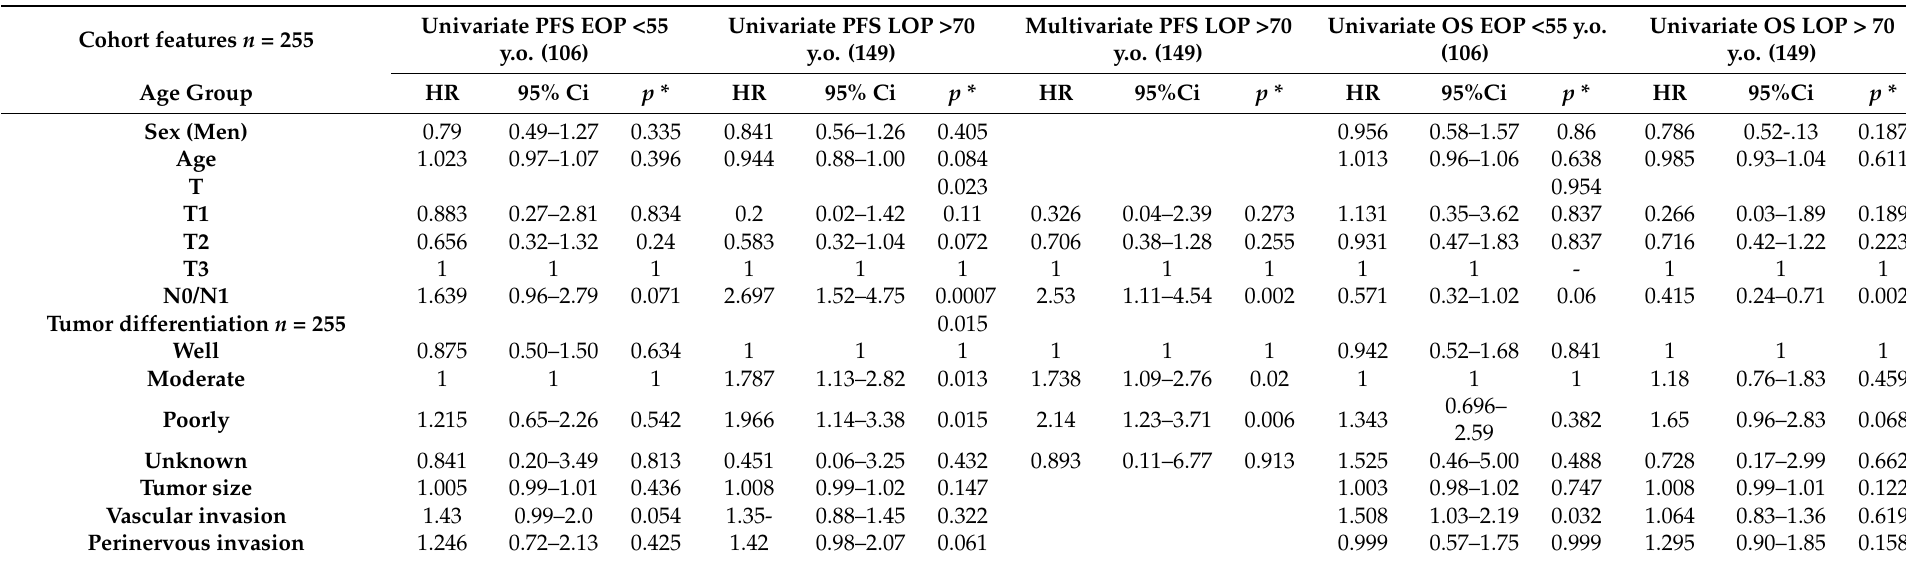
Table 2. Uni- and Multivariate analysis of Overall survival (OS) and Progression-free (PFS) survival of EOP and LOP from our multi-centric